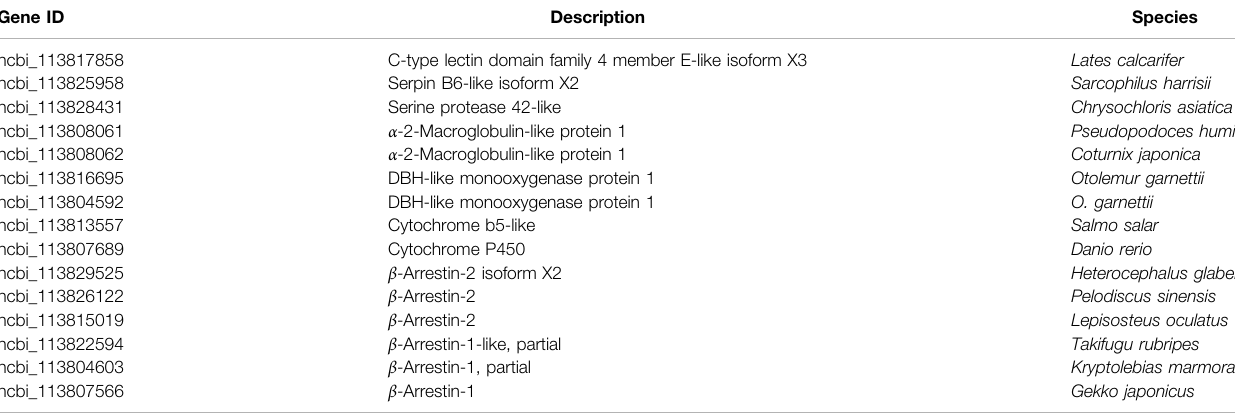
TABLE 5 | Immunity-related DEGs with high expression in VP AHPND -susceptible Litopenaeus vannamei families. Gene ID